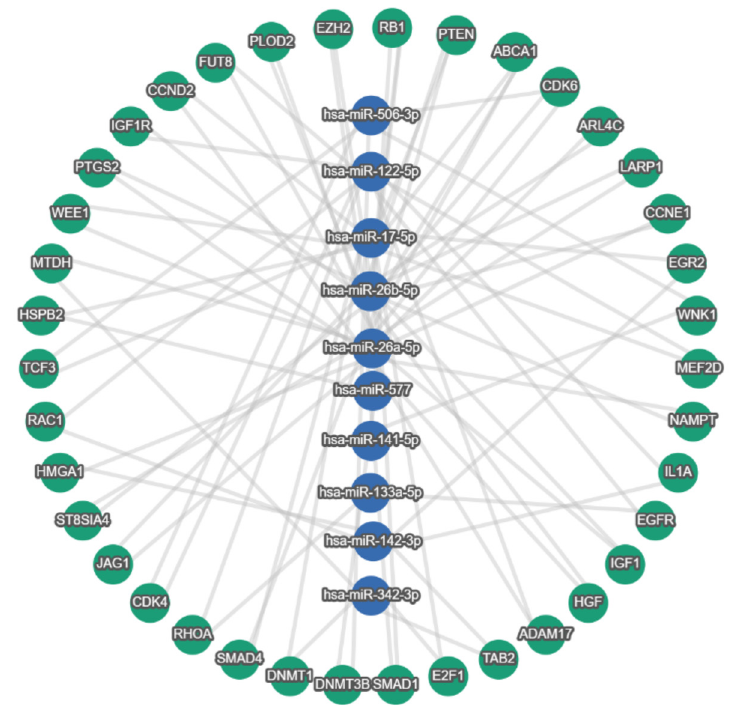
Figure 3. Strong experimentally validated shared target genes downstream of the CRC exosomal lncRNA/circRNA–miRNA–target axis. Green nodes indicate genes, and blue nodes indicate miRNAs. Minimum miRNA threshold = 2.